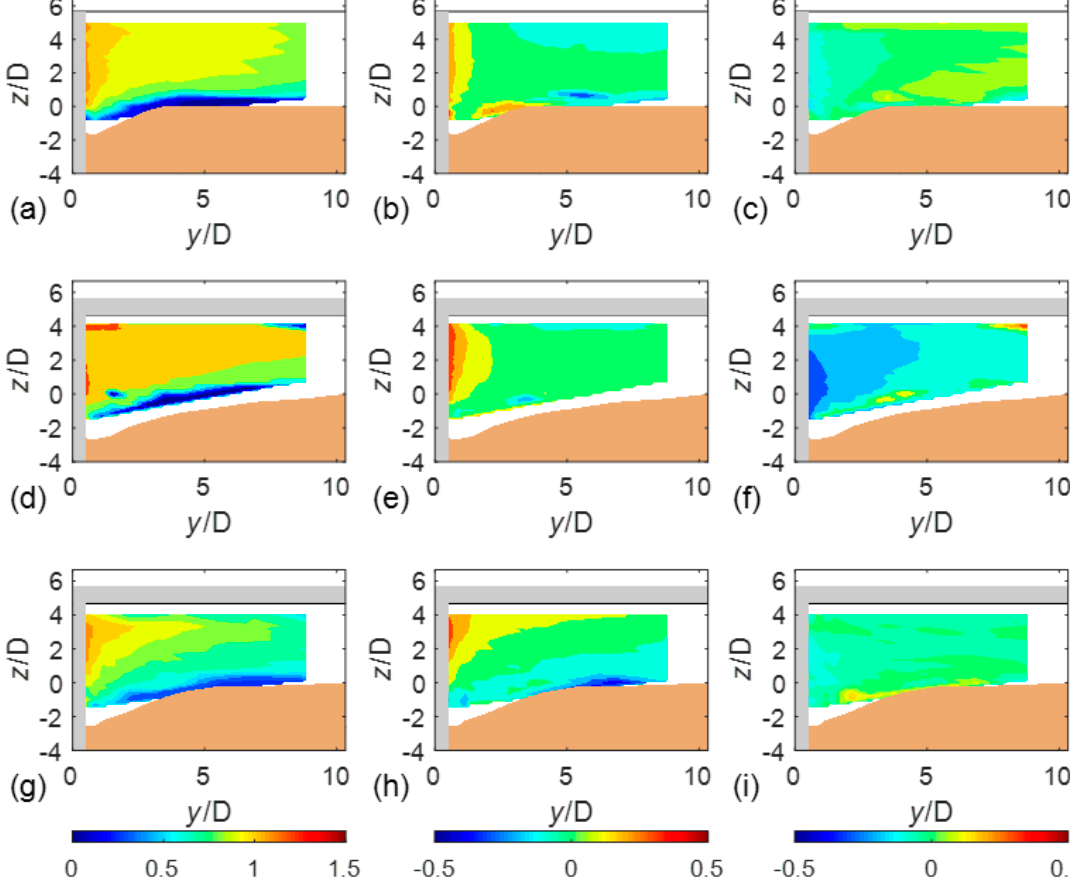
Figure 4. Average velocity components (in order left to right) u / U 0 , v / U 0 , and w / U 0 after 6 h of testing in mobile conditions for ( a – c ) pier without deck; ( d – f ) 3D deck and pier; and ( g – i ) 6D deck and pier.